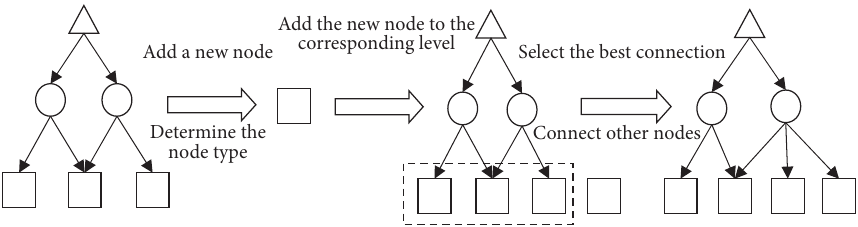
Figure 3: Add new nodes into the supply chain network.